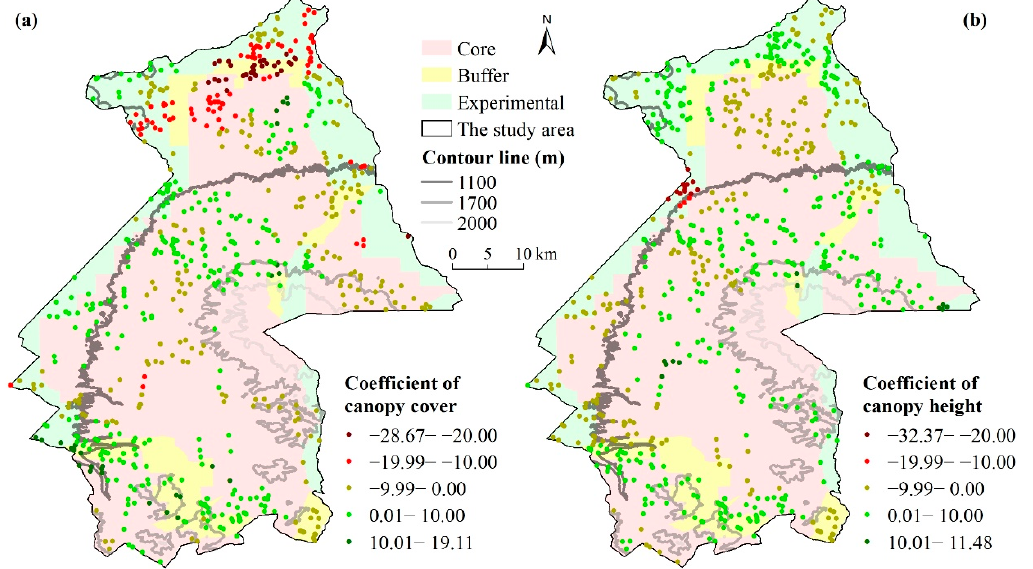
Figure 9. The location-specific coefficients of ( a ) canopy cover and ( b ) canopy height in the GWR model.